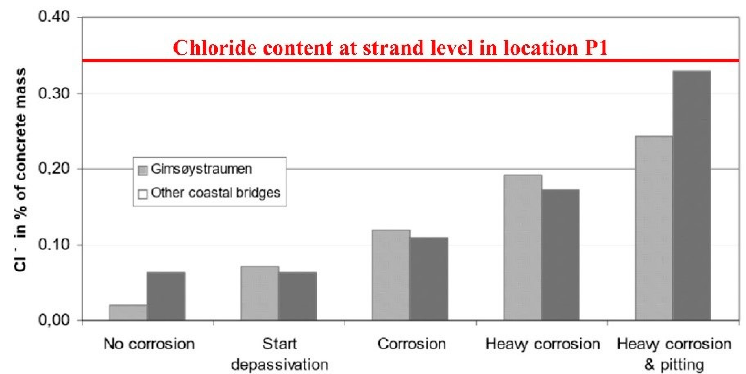
Figure 16. Relationships between corrosion severity and chloride content from more than 300 registrations on various coastal bridges in Norway [62]. Red line—chlorides at the strand level in location P1.